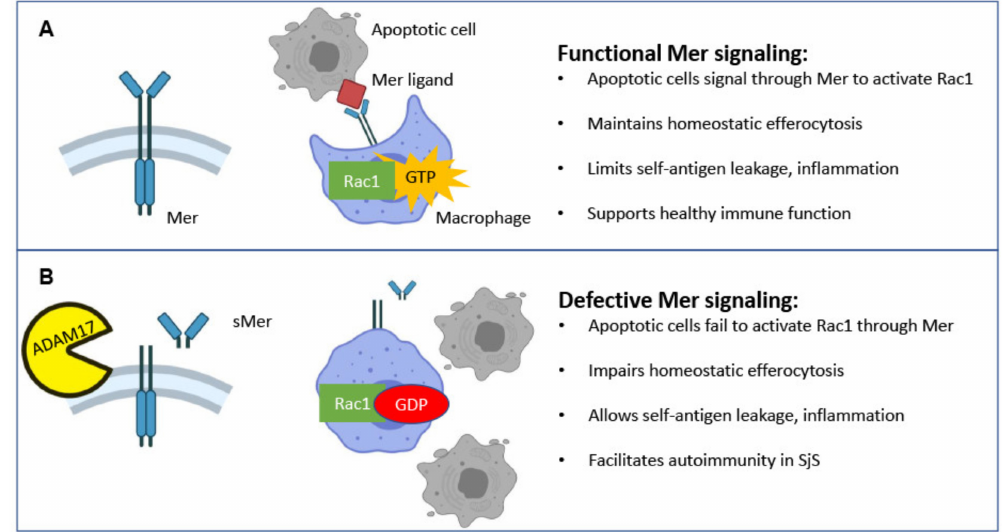
Figure 6. ( A ) Under healthy conditions, membrane-bound Mer on the surface of macrophages is activated by apoptotic cells, stimulating Rac1 activation and actin mobilization necessary for the uptake of apoptotic cells. The removal of apoptotic cells plays a critical role in maintaining self-tolerance by preventing the leakage of self-antigen from secondary necrotic cells. ( B ) The impaired efferocytosis mediates the autoimmune process of SjS with reduced Rac1 activation. This process is attributed to defective Mer signaling and excessive cleavage by activation of ADAM17